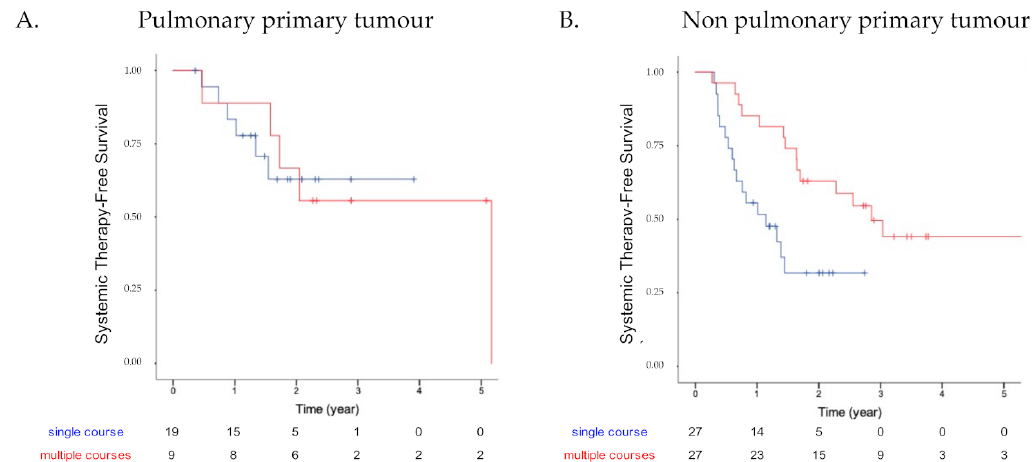
Figure 3. Kaplan–Meier curves showing the systemic therapy-free survival of the “single course” group (in blue) and “multiple courses” group (in red) in pulmonary primary tumor only ( A ), and in other primary localizations ( B